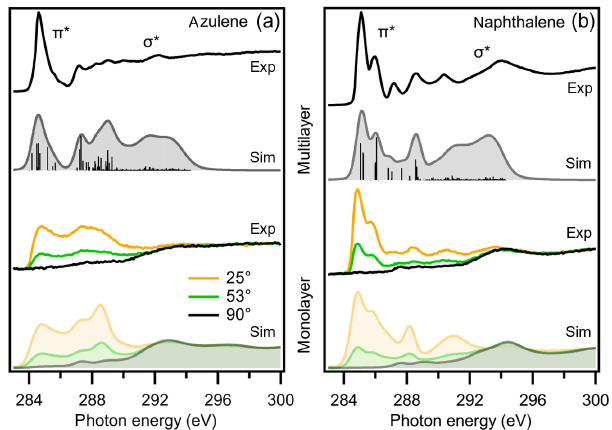
FIG. 5. Experimental carbon K-edge NEXAFS spectra and corresponding DFT simulations for (a) azulene and (b) naphtha- lene. Upper part: Multilayer spectra and simulations for the free molecule. The multilayer spectra were taken with the electric field vector oriented 90° relative to the surface normal. Lower part: Monolayer spectra and simulations for different angles of the electric field vector relative to the surface normal as indicated. The simulations for the free molecules are displayed both as isolated excitations and after broadening; the simulations for the monolayers are only shown in broadened form. For the broad- ening, each excitation is represented by a pseudo-Voigt peak with an increasing width and Lorentzian contribution at higher photon energies. The simulated spectra were shifted by − 6 . 1 eV to match the experimental data.